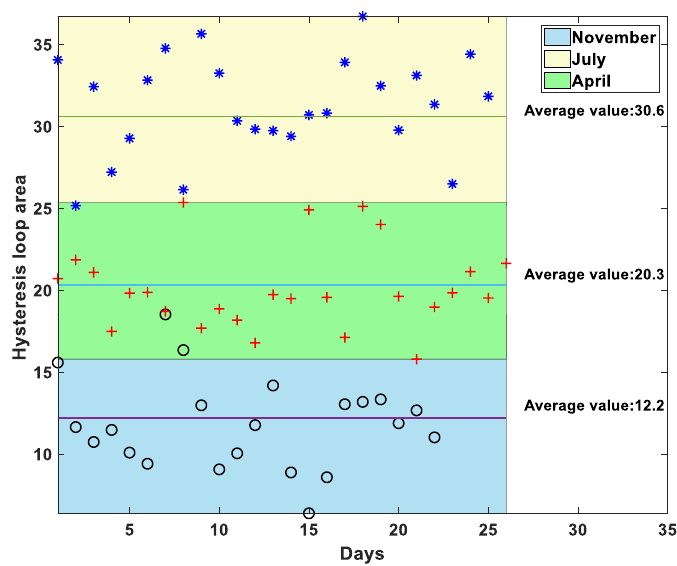
Figure 4. Hysteresis loop area in three months of 2017.